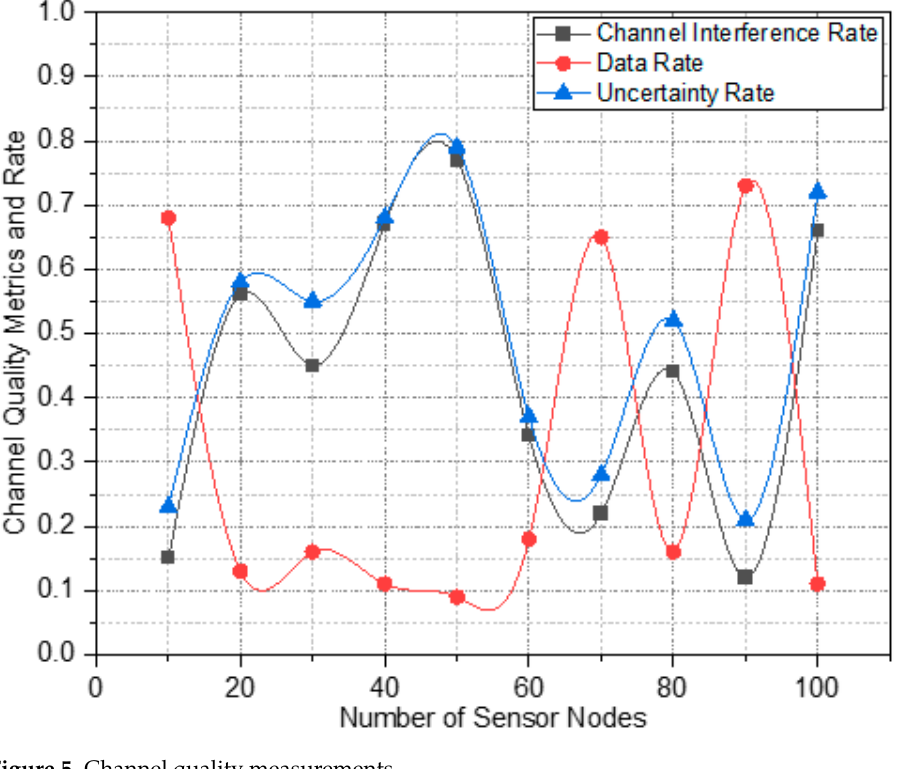
Figure 5. Channel quality measurements.